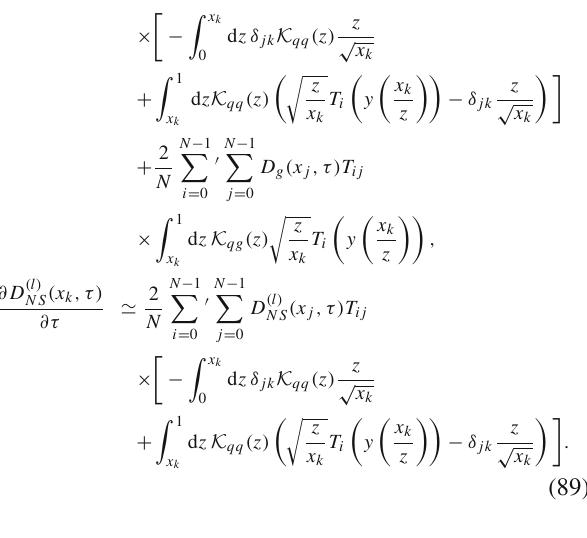
Fig. 15 Comparisons of the k T distributions from MINCAS and TMDICE for the evolution equations (20) with w( l ) ∝ 1 / [ l 2 ( m 2 time-scales t = 0 . 1 and 4fm: cascades initiated by gluons (left) and quarks (right). The bottom panels show the ratios to the corresponding results from